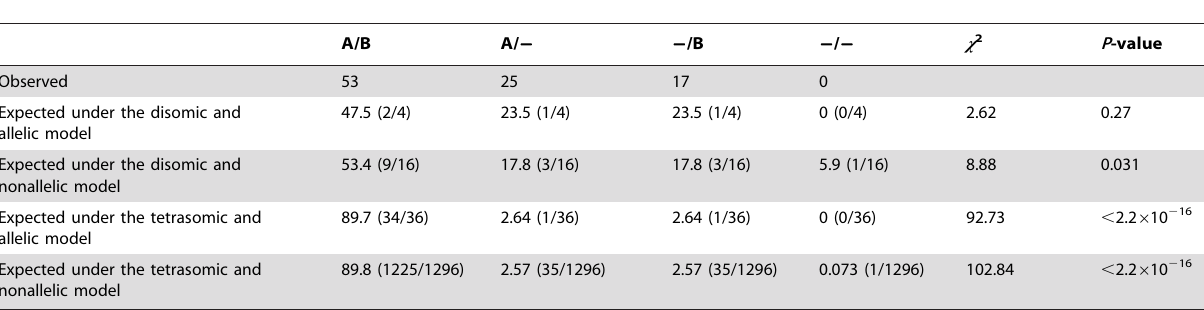
Table 1. The pattern of segregation of AkSRK-A and AkSRK-B in 95 F 2 individuals.